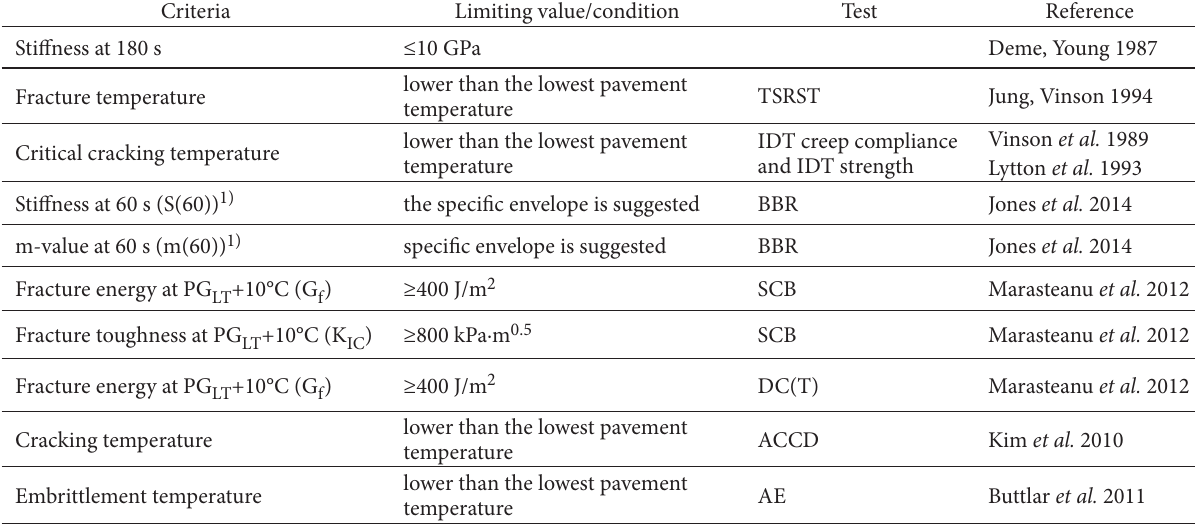
Table 2. Limiting criteria for asphalt mixture resistance to low temperature